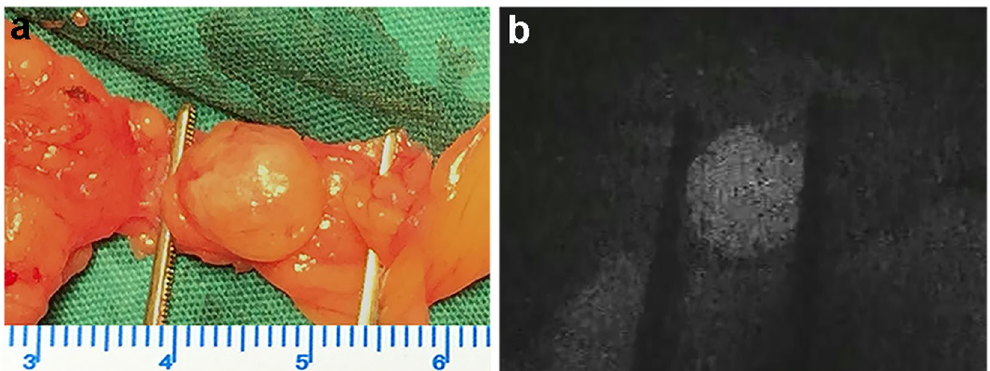
Figure 5. Bright-field ( a ) and fluorescent image ( b ) of the ectopic PTG in